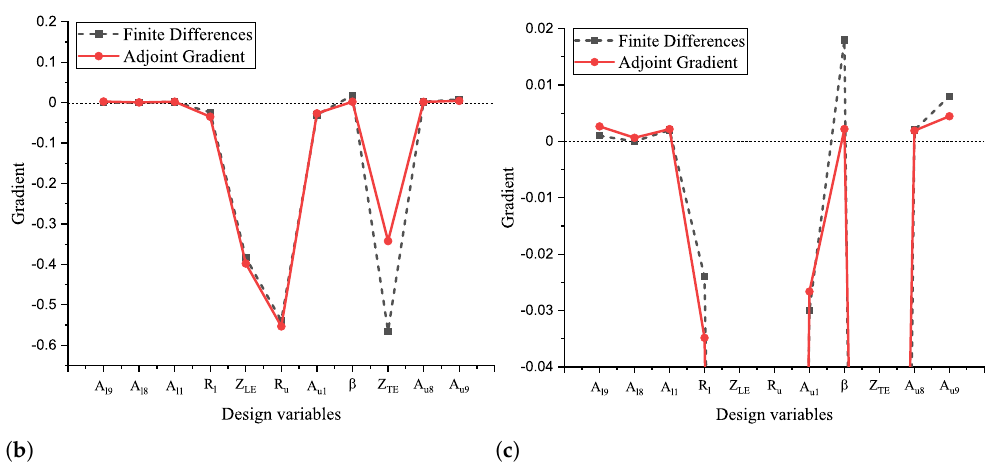
Figure 7. Adjoint surface sensitivity and a comparison of the projected gradient with results obtained from finite difference on RAE 2822 with drag as the objective function. ( a ) Surface sensitivity. ( b ) Gradient. ( c ) A zoom of